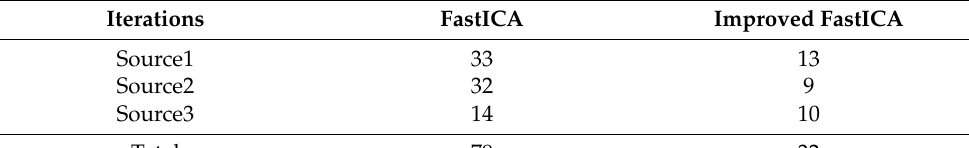
Table 5. The number of iterations corresponding to the separated two source signals in a certain run.